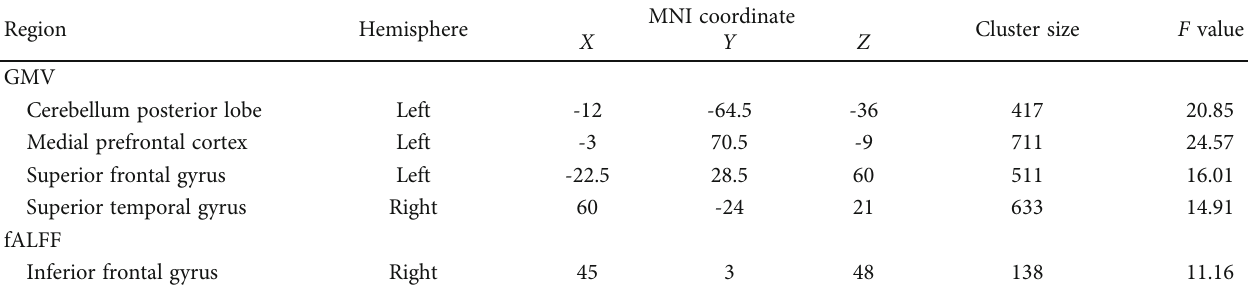
Table 4: Brain regions showing signi fi cant di ff erences in GMV and fALFF values among the PSND, PSD, and NC groups. Region